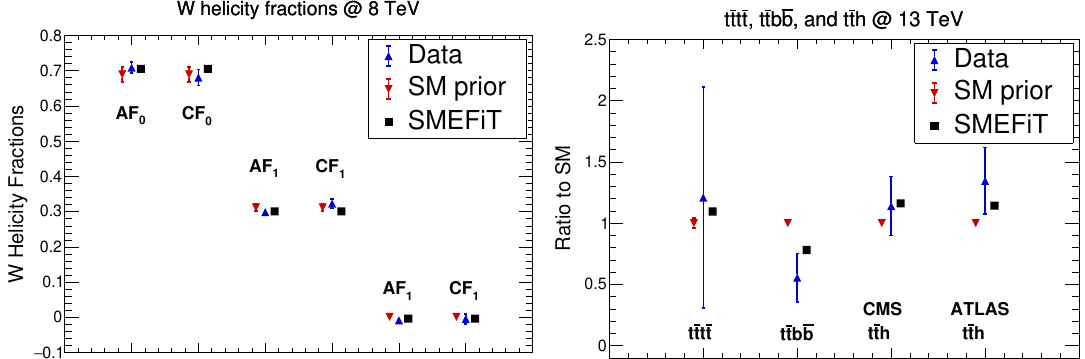
Figure 16 . Left: same as (cid:12)gure 13 for the W helicity fractions F CMS. Right: the corresponding comparison between data and theory predictions for the CMS measurements of t (cid:22) tb (cid:22) b and t (cid:22) tt (cid:22) t at 13 TeV, as well as for the t (cid:22) th cross-section measurements from ATLAS and CMS at 13